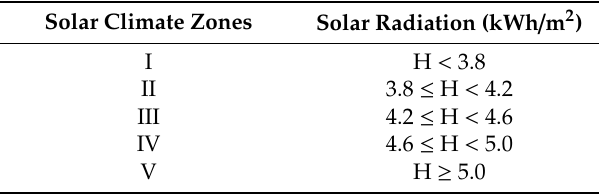
Table 11. Average altitude of the different study cases in the calculation of solar energy.